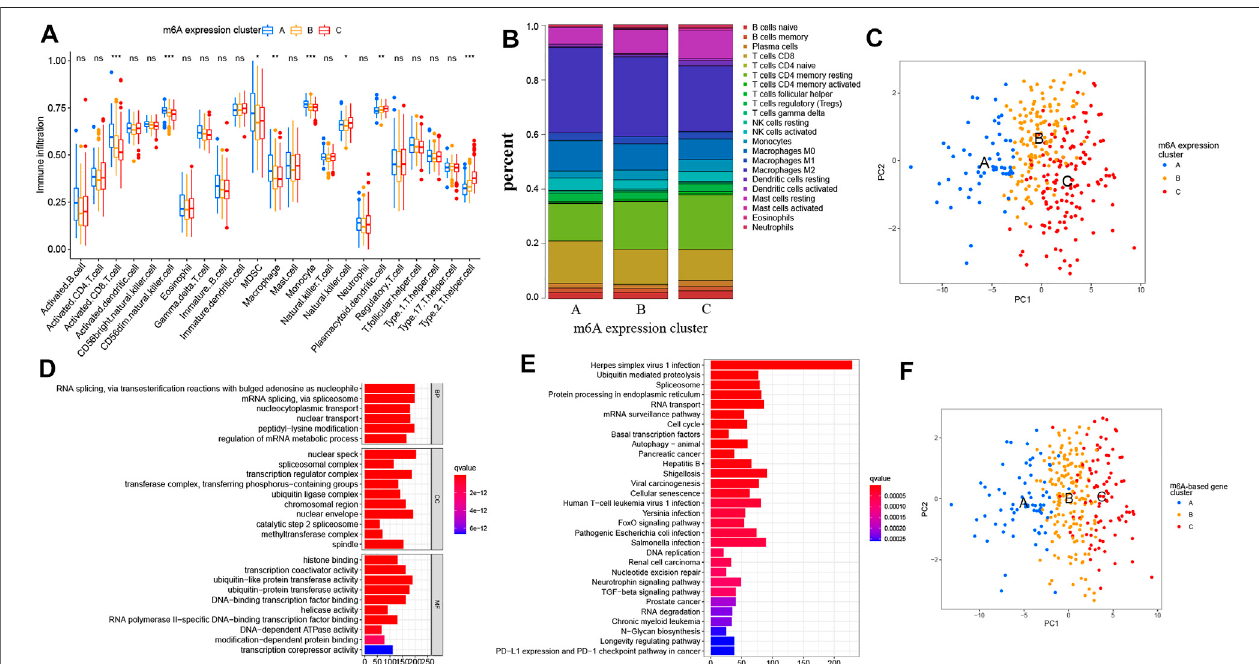
FIGURE 3 | Characteristics of TME cell in fi ltration in diverse m 6 A expression clusters and the construction of m 6 A gene signatures. (A) Abundance of TME-related immunecellsinthreem 6 Apatterns. Thehistogramshowstheexpressiondifferenceof23kindsofimmunecellsbetweenm 6 Aexpression clusterA,B,and C.Theupper and lower ends of the boxes mean interquartile range (IQR) of the values. The lines in the boxes represent each the median value. The asterisks represent the p value. (* p < .05;** p < .01;*** p < .001) (B) ProportionofdifferentTME-relatedimmunecellsinthethreem 6 ApatternsasanalyzedbyCIBERSORT. (C) Principalcomponent analysis of PRCC patients in three m 6 A expression clusters, which indicates a remarkable difference between the different modi fi cation patterns. (D , E) Functional analysis for m 6 A-related genes. (D) GO enrichment analysis. (E) KEGG enrichment analysis. MF means molecular function, CC means cellular component, and BP meansbiologicalprocess. (F) PrincipalcomponentanalysisofPRCCpatientsforthethreem 6 A-basedgeneexpressionclusters.Theleftpartofeach fi gureindicatesthe biological functions and signaling pathways. The degree of enrichment is represented by the color depth of each bar